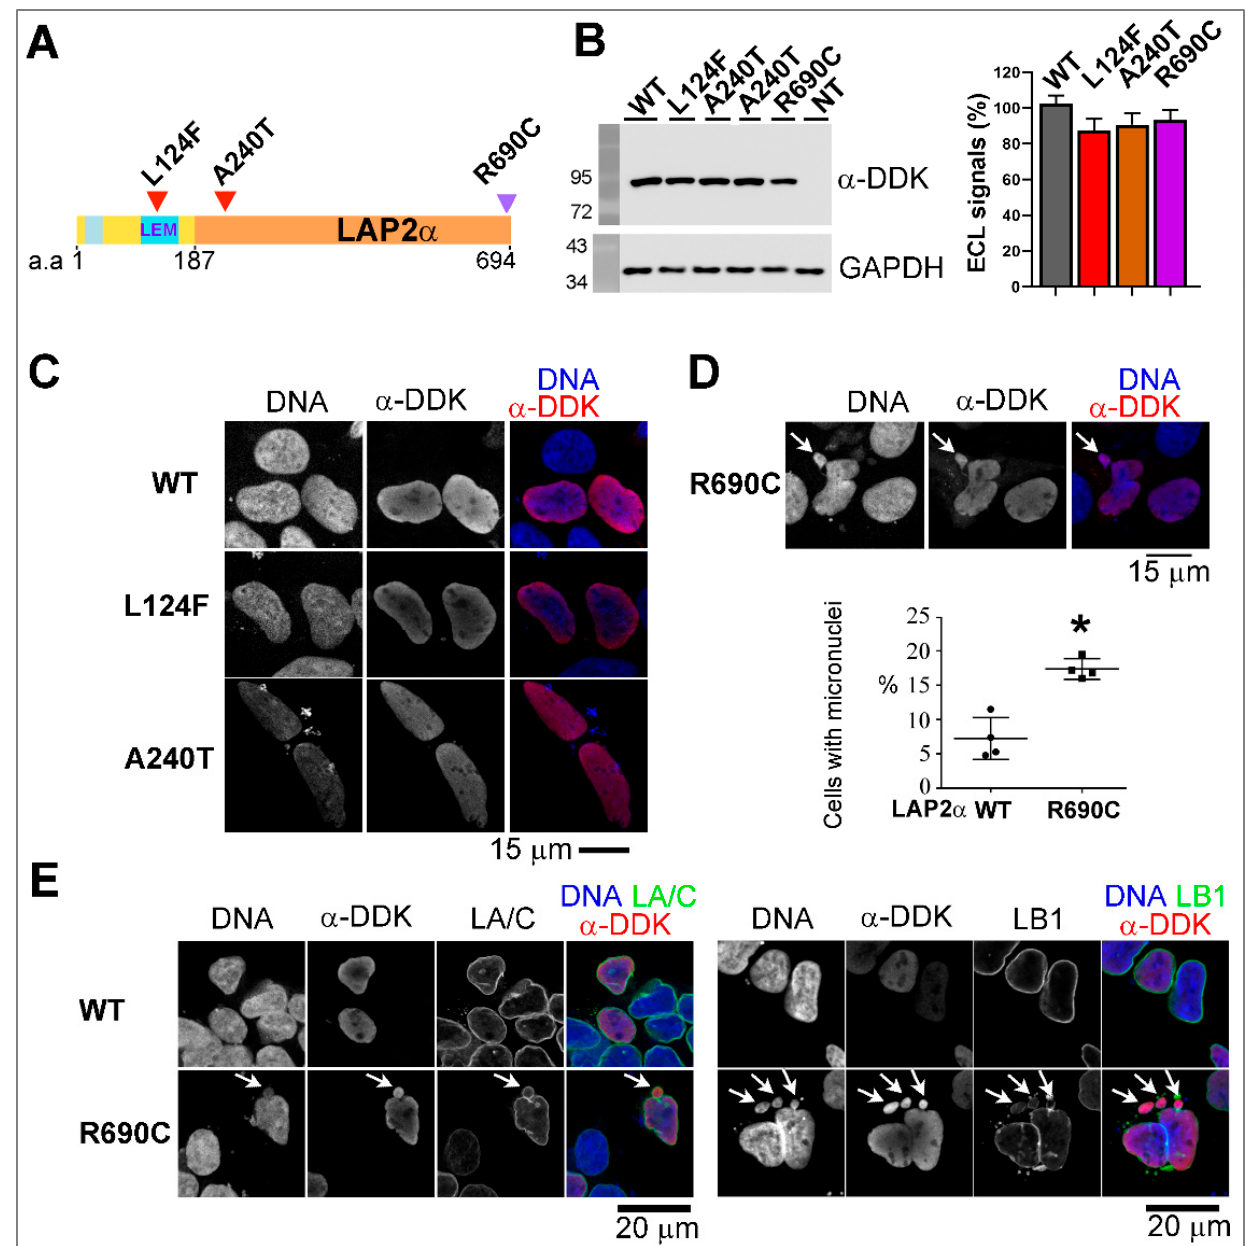
Figure 6. Impact of LAP2 α missense variants expression on nuclear phenotypes. ( A ) Secondary structure of exogenous LAP2 α . Arrowheads indicate the position of the mutations p.(Leu124Phe) (L124F), p.(Ala240Thr) (A240T) and p.(Arg690Cys) (R690C). ( B ) Western blot on whole extracts of HEK293 cells either non-transfected (NT) or overexpressing wild-type (WT) or mutant LAP2 α -DDK proteins using anti-DDK or anti-GAPDH antibodies. The graph shows ECL signal quantification (relative to DDK; mean ± s.e.m; n = 9 (WT, R690C), n = 8 (L124F) or n = 5 (A240T) experiments. ( C ) HEK293 cells overexpressing WT or mutant (L124F, A240T) LAP2 α -DDK labeled with anti-DDK (red) antibodies. ( D ) HEK293 cells overexpressing mutant (R690C) LAP2 α -DDK labeled with anti- DDK (red) antibodies. Arrows show micronuclei. The graph shows the percentage of cells with mi- cronuclei (mean ± SD, n = 4 experiments). * p < 0.05 (Mann–Whitney test). ( E ) HEK293 cells overex- pressing WT or mutant (R690C) LAP2 α -DDK labeled with anti-DDK (red) antibodies mixed with anti-lamin A/C (LA/C, green) or anti-lamin B1 (LB1, green) antibodies. Arrows show micronuclei. In ( C–E) , DNA was stained with Hoechst (blue). Scale bars = 15 or 20 µm, as indicated.